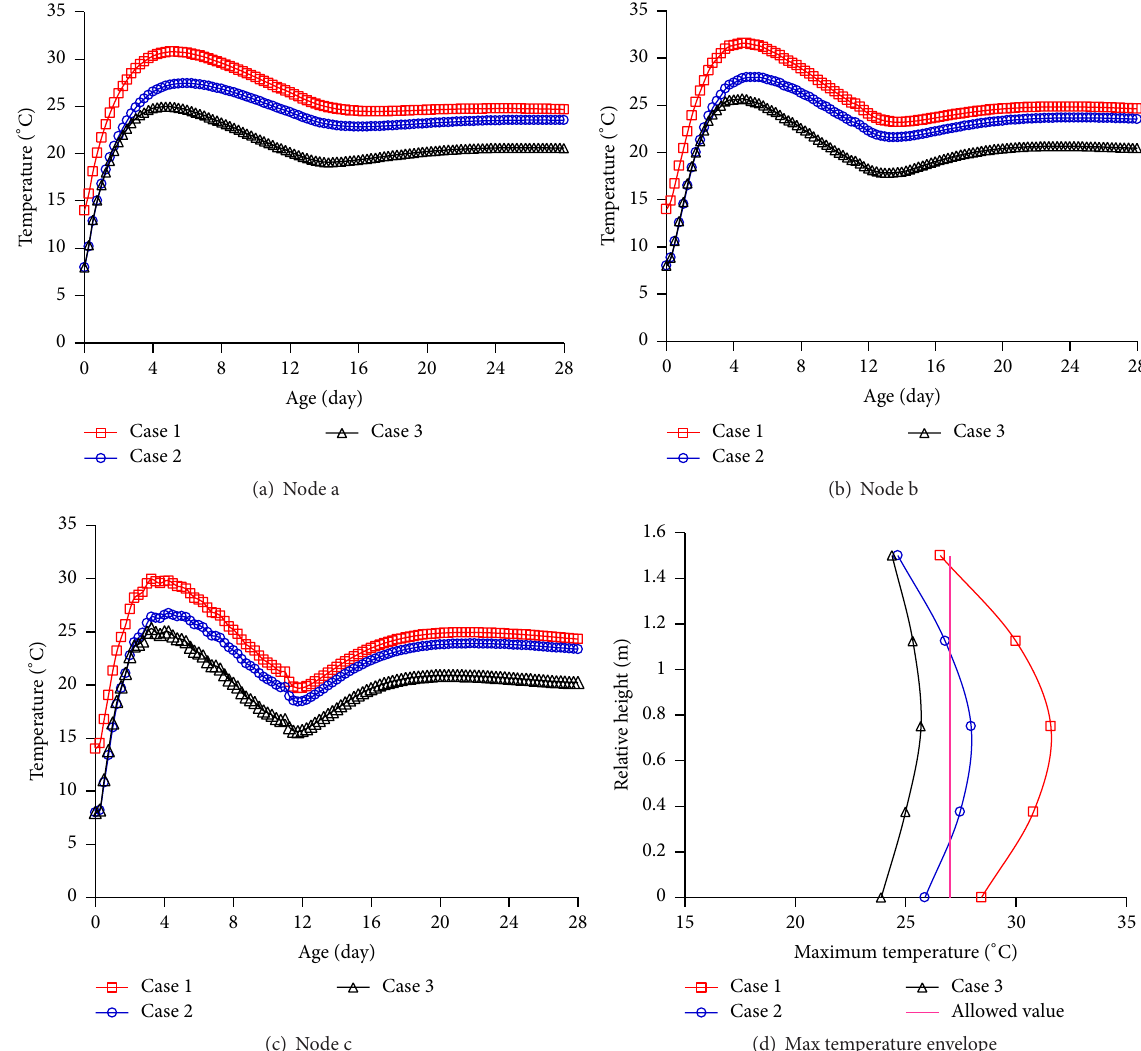
Figure 14: The temperature prediction results of typical points (nodes a, b, and c: 𝑥 = 16 , 𝑦 = 36